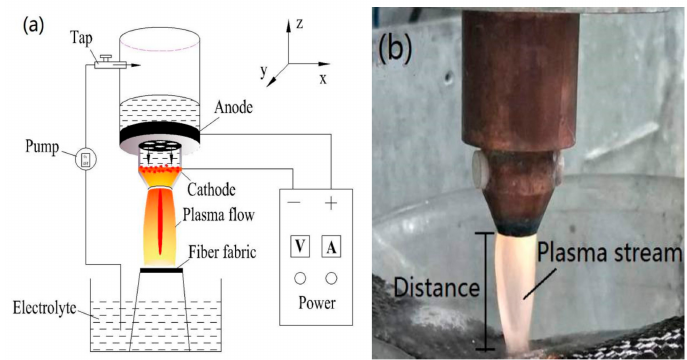
Figure 1. ( a ) Schematic diagram of the electrolytic plasma spraying; ( b ) Photo of the cathodic plasma flow taken during the